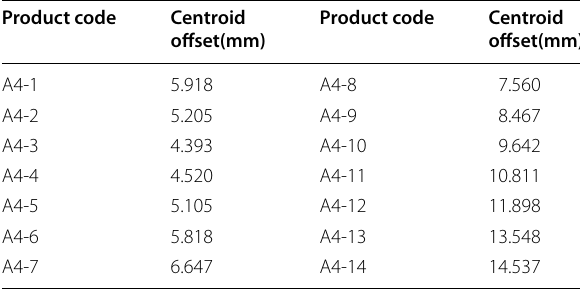
Table 2 Centroid offset data of fourth batch of cabin